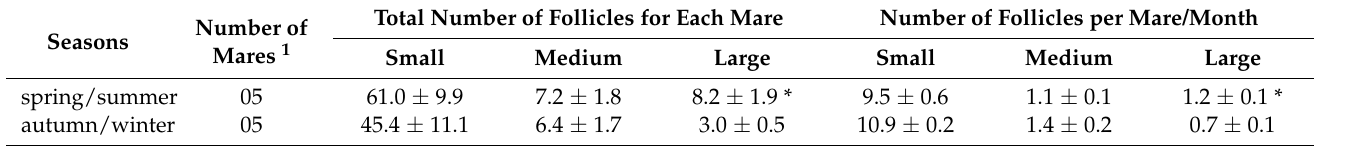
Table 2. Seasonal distribution of the number of follicles (Means ± SEM) evaluated one day before the follicular cell